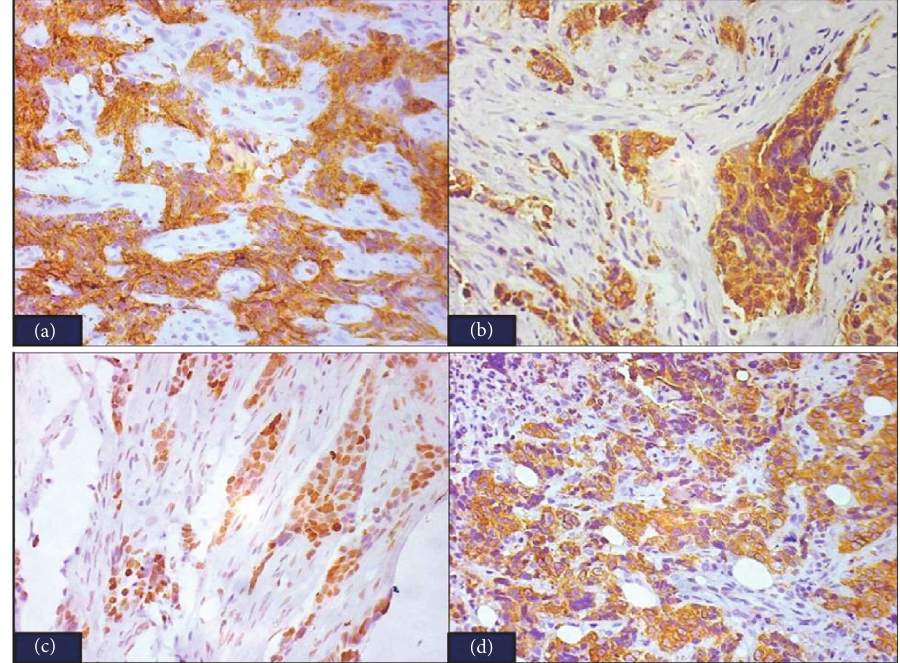
Figure 2: (a) Immunohistochemical staining for CD5 shows strong, diffuse cytoplasmic staining of the tumor cells ( × 200). (b) Bcl-2 cytoplasmic immunopositivity of the tumor cells ( × 200). (c) Immunohistochemical staining for p53 shows strong nuclear staining of the tumor cells ( × 200). (d) Tumor cells exhibiting positive CD117 expression ( ×